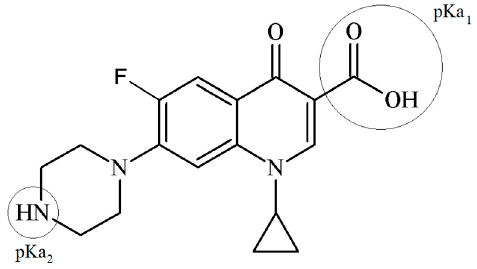
Figure 1. Ciprofloxacin structure